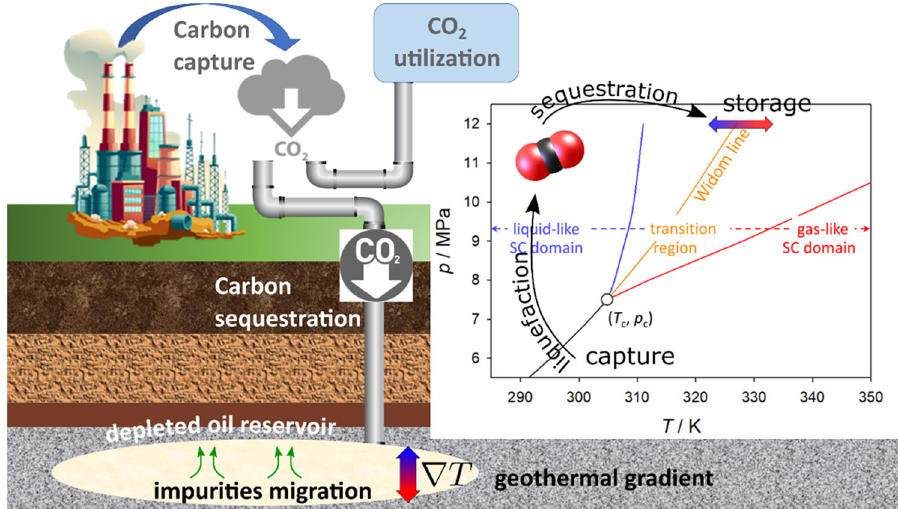
Fig. 4 Carbon capture and sequestration. Schematic representation of carbon capture and sequestration in reservoirs. The inherent temperature gradient induces thermal diffusion of impurities from the bottom to the cap-rock of the reservoir. During injection, sequestration and storage, CO 2 goes through different thermodynamic states as depicted in the right panel. The temperature and pressure dependence of the Widom line for pure CO 2 was determined by the maxima of the isobaric heat capacity. The area between the blue and red lines represents the transition region between the liquid-like and gas-like subdomains of the supercritical fl uid. Image of thermal-power plant by vectorpocket on Freepik.com (https://www.freepik.com/free-vector/heavy-industry-factory-working-thermal- power-plant-station-with-electricity_4758475.htm).